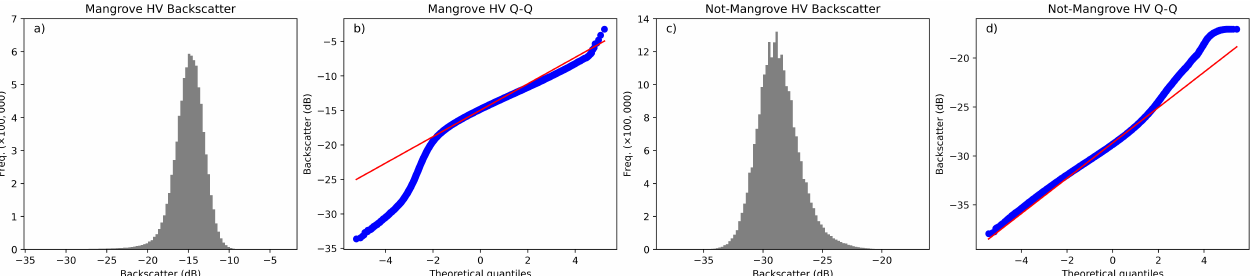
Figure 4. Example histograms with the thresholds for defining ( a ) mangrove and ( b ) non- mangrove thresholds.